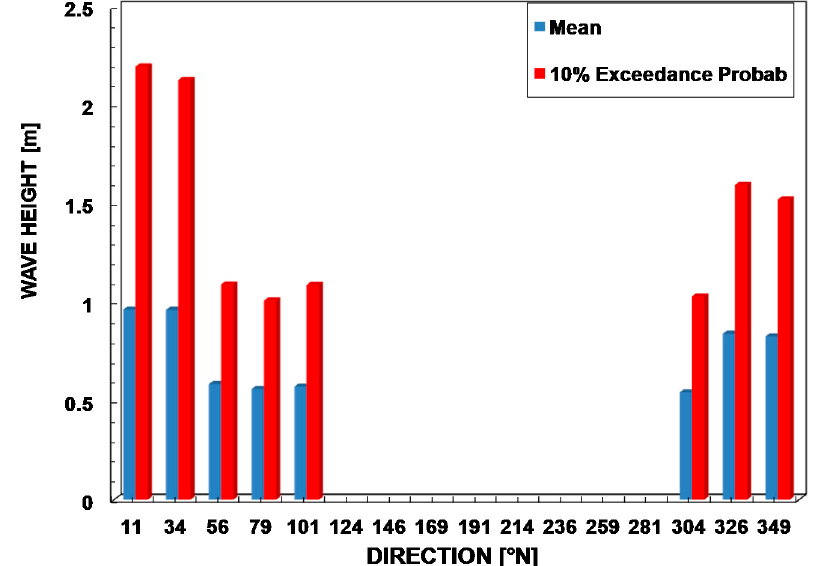
Figure 3. Histogram of the wave directions. Onshore directed angles are removed.